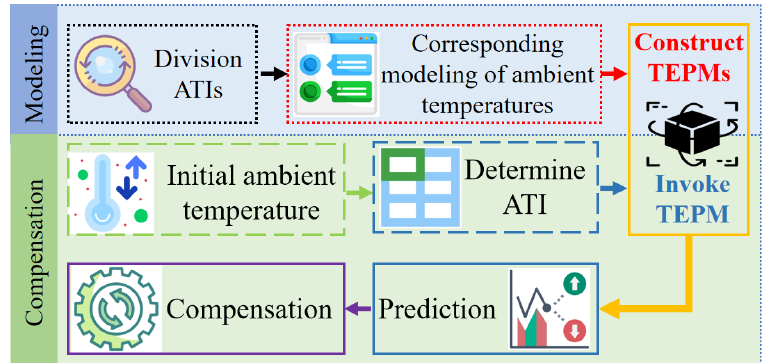
Figure 8. Flowchart of the modeling and compensation method based on ATIs.